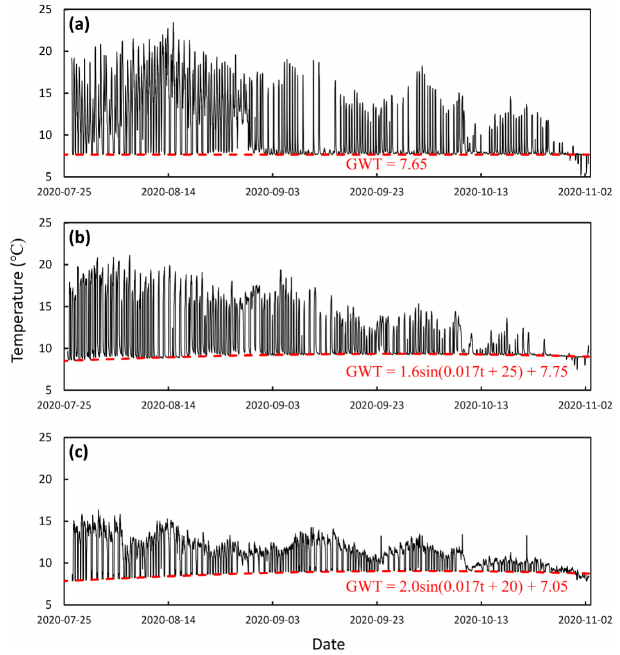
Figure 7. Temperature data (black) from the mouths of (a) Spring 5, (b) Spring 21, and (c) Spring 2 (see Table S2 and Fig. S7 for lo- cations) vs. date (yyyy-mm-dd) from Basin Head lagoon. The fitted annual temperature sine wave (GWT; in red) has a distinguishable amplitude in Springs 21 and 2 but not in Spring 5. GWT is the an- nual groundwater temperature waveform, and t is the time in days.